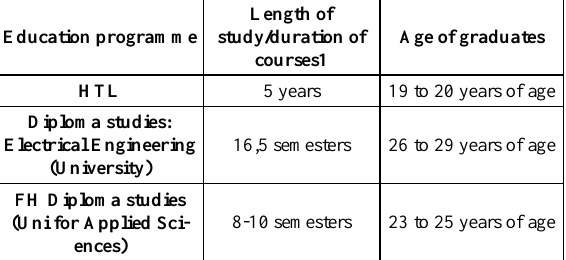
TABLE I. C OMPARISON OF DIFFERENT E DUCATION P